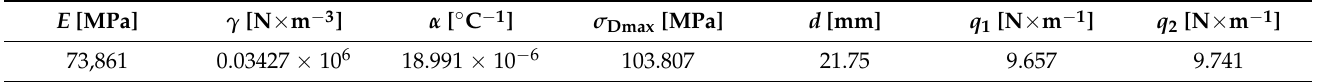
Table 1. Mechanical parameters of the selected conductor ACSR 240/39.